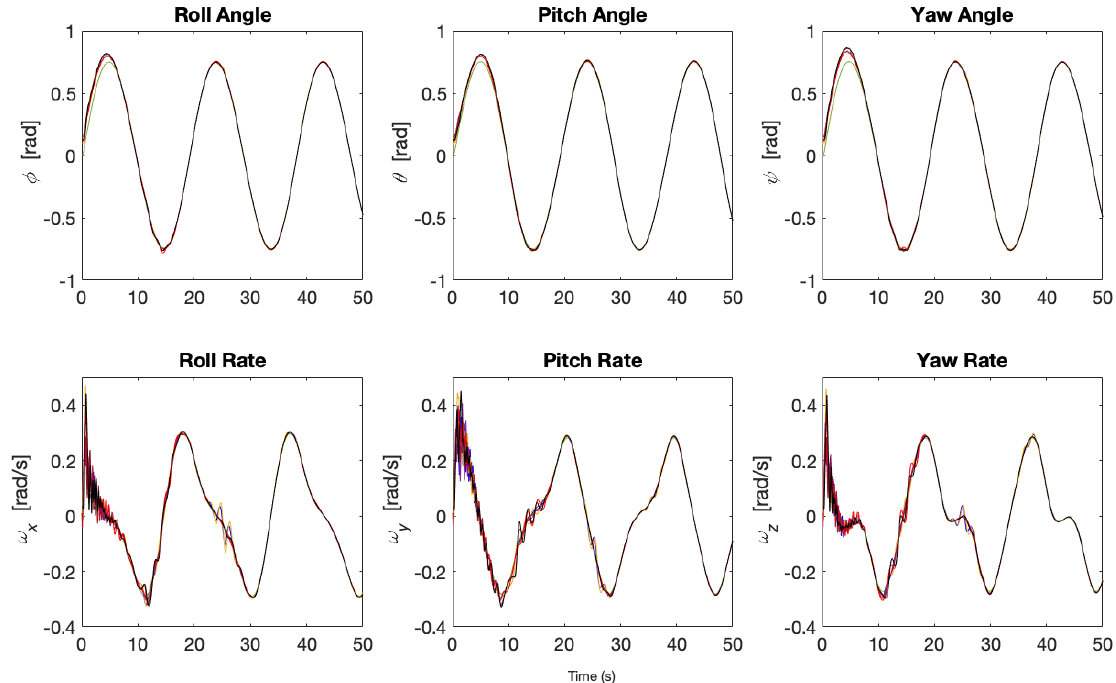
Figure 4. Adaptive spacecraft state synchronization for states ( φ , θ , ψ , ω x , ω y , ω z ) ( µ =